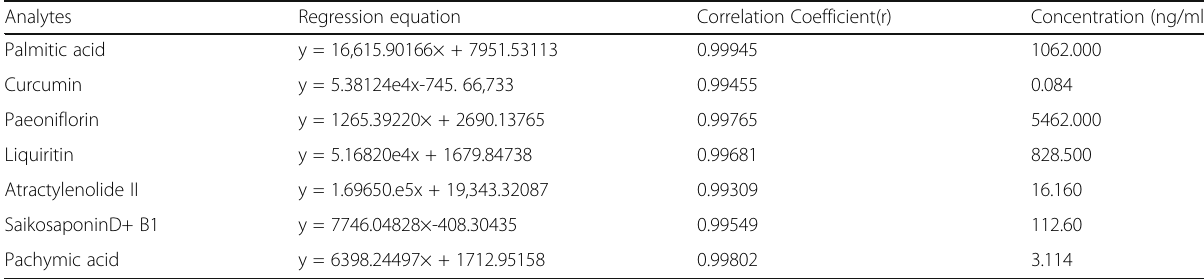
Table 3 Linearity and concentrations of eight ingredients in XYS sample